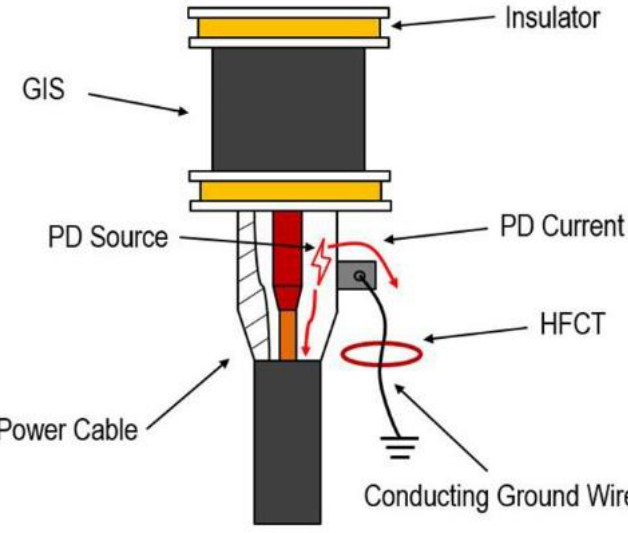
Figure 1. Partial discharge (PD) detection mechanism using the high-frequency current transformer (HFCT).